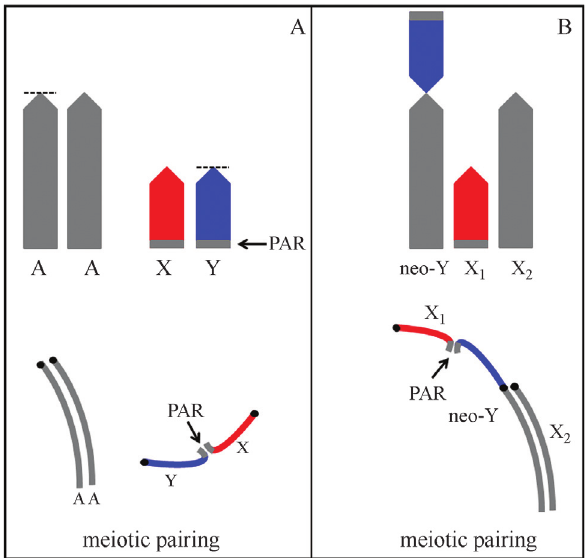
Figure 4 - Probable mechanism of evolution of the X 1 X 2 Y sex systems in Brachyhypopomus :anancestralhomomorphicXX/XYsexsystem(A)un- derwent a fusion between an autosome and the Y chromosome (B) origi- nating a multiple X 1 X 2 Y system.